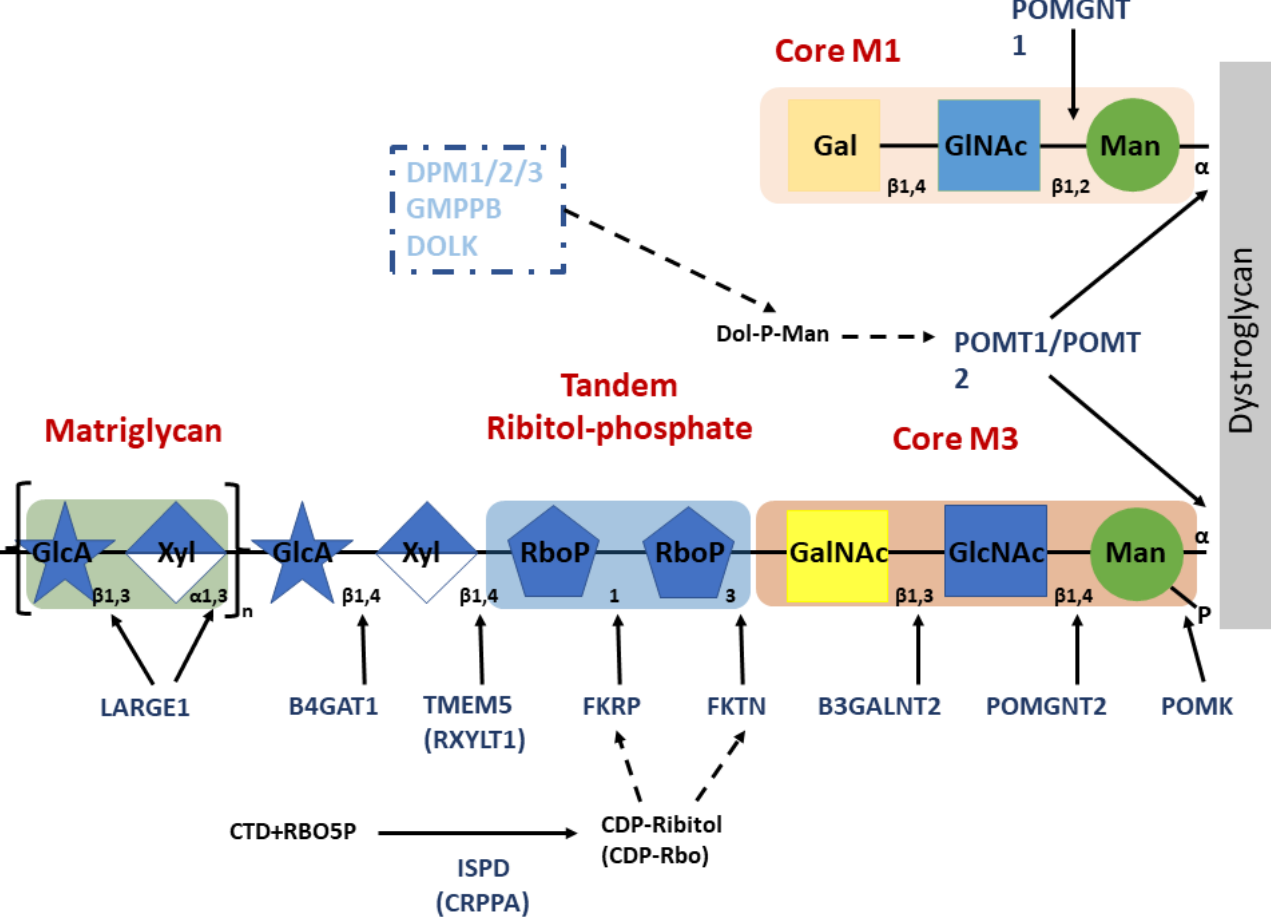
Figure 4. Representation of the sequence of genes involved in the O-Glycosylation of α-DG and matriglycan formation. Man, mannose; GlcNAc, N-acetylglucosamine; GalNac, N-acetylgalactosamine: RboP, ribitol phosphate; Xyl, xylose; GlcA, glucronic acid; Gal, galactose; Rbo5P, ribitol-5-phosphate; POMT1, Protein O-mannosyl-transferase 1; POMT2, Protein O-mannosyl-transferase 2; POMGNT1, Protein O-mannose β1,2-N-acetylglucosminytranferase 1; POMGNT2, Protein O-mannose β1,4-N-acetylglucosminytranferase 2; TMEM 5, transmembrane protein 5; RXYLT1, ribitol-5-phosphate xylosyltransferase 1; B4GAT1, β1,4-glucuronyltransferase; B3GALNT2, β1,3-N_acetylgalactosaminyltransferase; POMK, Protein O-mannose Kinase; FKTN, Fukutin; FKRP, Fukutin related protein; LARGE1, like-acetylglucosaminyltransferase/LARGE xylosyl-and glucoronyltransferase 1; ISPD, isoprenoid synthase domain-containing protein; CDP-ribitopyrophosphorylse